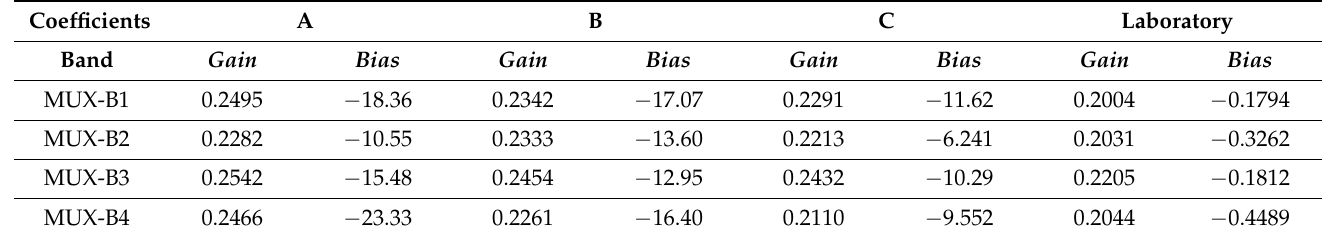
Table 5. Different radiometric calibration coefficients (in units of